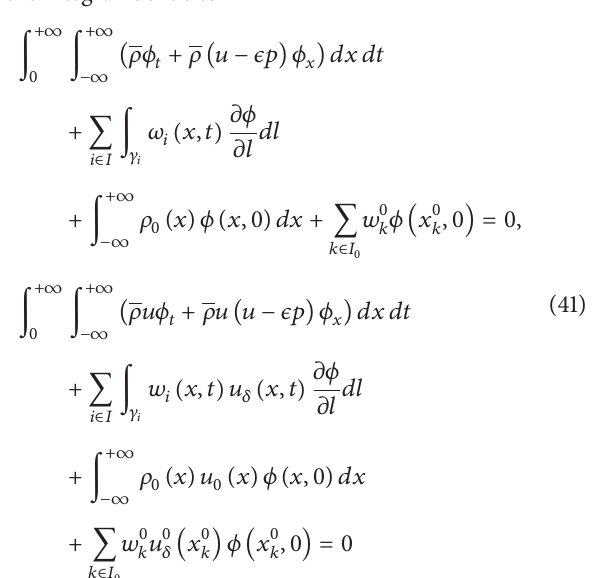
type solution of system (9) with the initial data (𝑢 0 (𝑥), 𝜌 0 (𝑥))